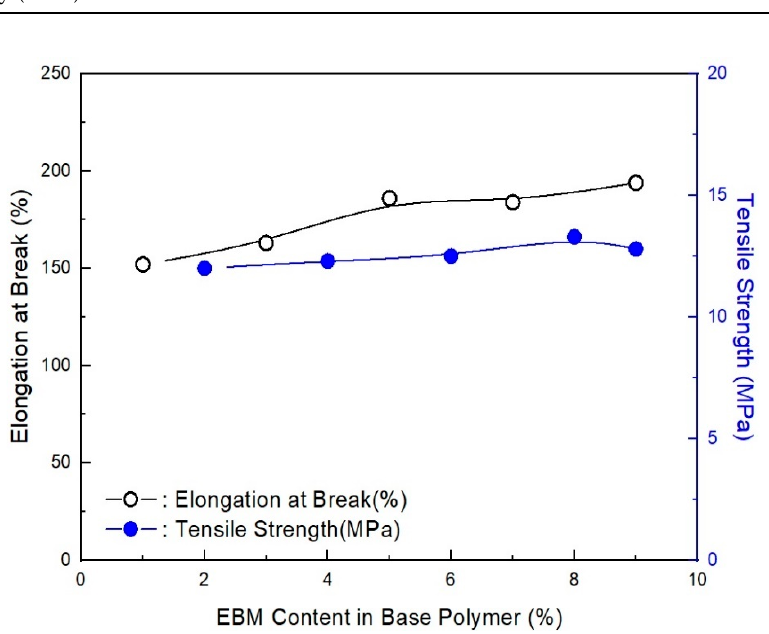
Figure 18. Tensile strength and elongation at break of EVA/EXACT 8201/CLNA ‐ 8400/125 phr flame ‐ retardant (MH+ZB+RP) formulations as a function of EBM content.